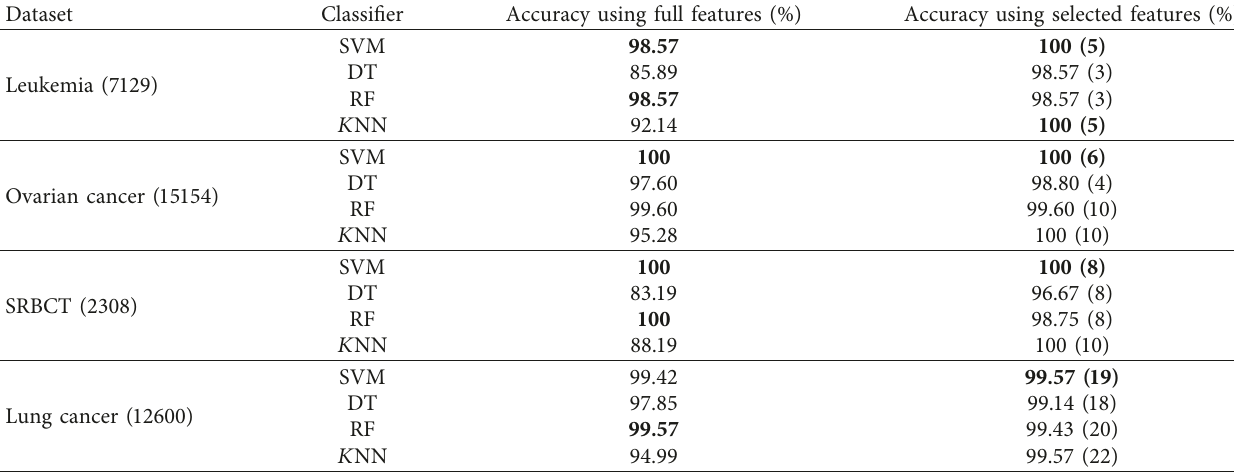
Table 8: Average classification accuracy using four classifiers on four biological datasets. The number of features is shown in parentheses. The best results are shown in bold font.